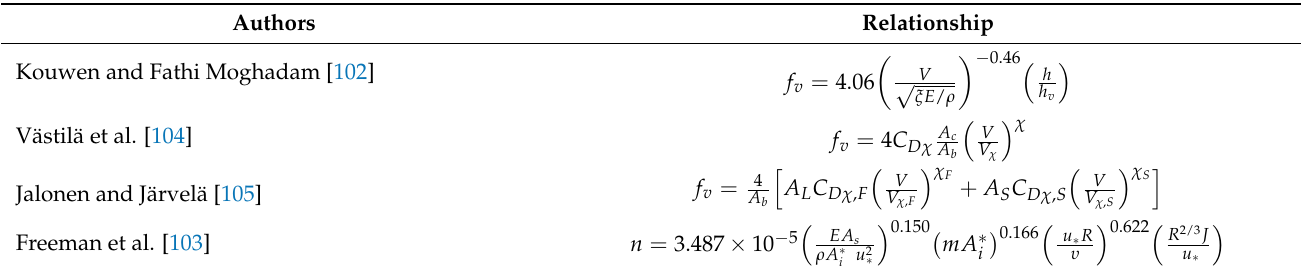
Table 4. Equations for estimating f v and n in case of non-submerged flexible